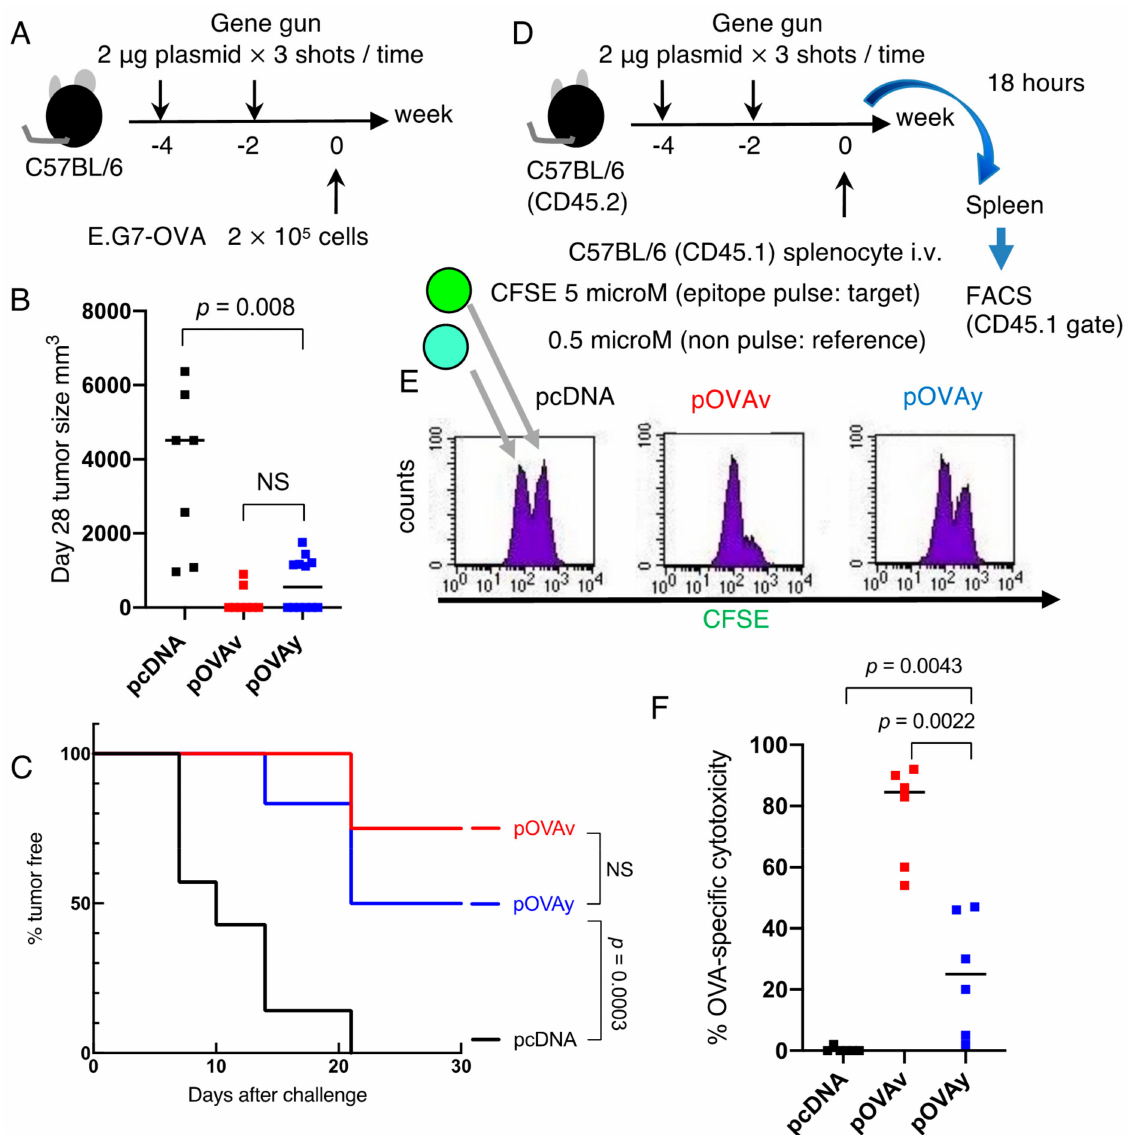
Figure 3. Comparison of pOVAv and pOVAy with two-time vaccine administration for anti-tumor immunity and OVA- specific cytotoxicity. ( A ) C57BL/6 mice were immunized twice with DNA vaccine via gene gun at two-week intervals. At week 0, the mice were challenged with E.G7-OVA. ( B ) Tumor size at day 28. Each symbol is indicative of an individual mouse. ( C ) Percentage of tumor-free mice with two-time immunization with pOVAv, pOVAy, or pcDNA. All data are